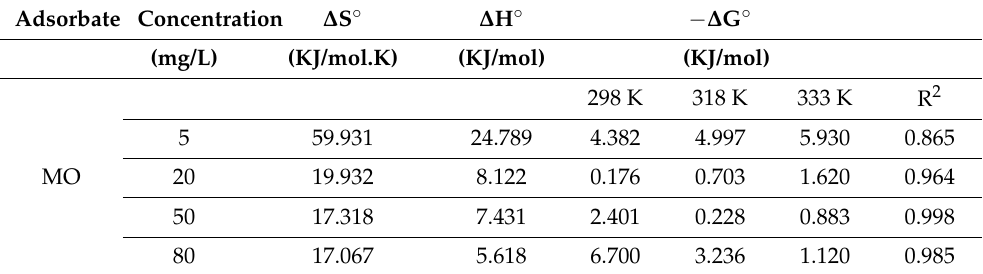
Table 2. Thermodynamic parameters of MO adsorption onto LIG/TiO 2 .